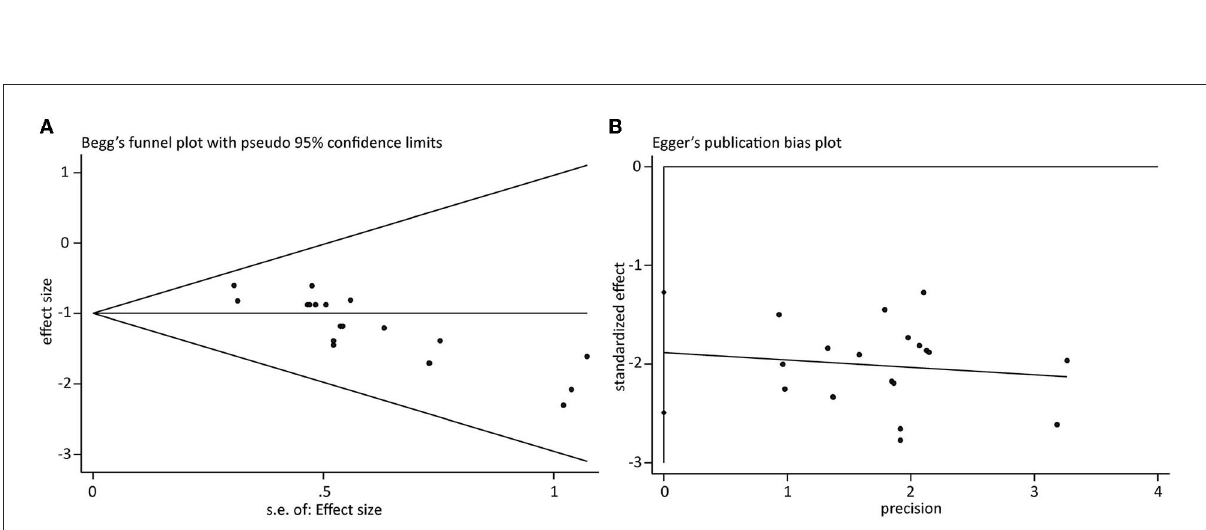
FIGURE6 Publication bias examination based on (A) Begg’s funnel plot and (B) Eggr’s funnel